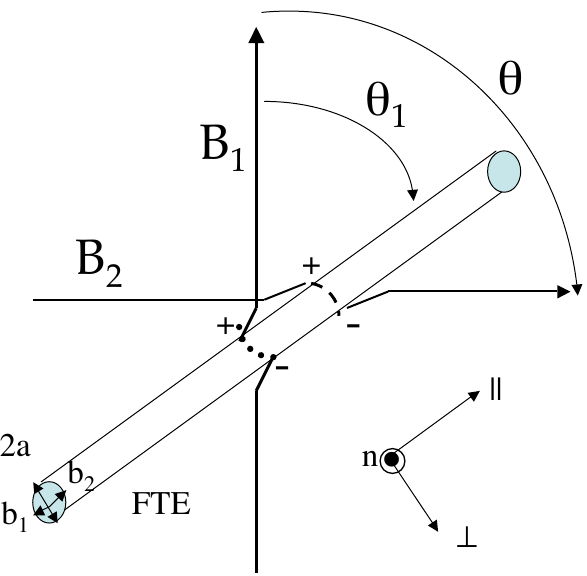
Fig. 1. A view of the dayside magnetopause from the Sun. The shear angle between the magnetosheath ( B 2 ) and magnetospheric ( B 1 ) magnetic fields is θ , whereas the angle between the axis of the FTE and the magnetospheric magnetic field is θ 1 . The northward magnetospheric magnetic field drapes under, whereas the duskward magnetosheath magnetic field drapes over, a flux transfer event whose axis runs from southern dawn to northern dusk. The draped field gains a positive (+ B n ) component normal to the nominal mag- netopause in both the magnetosheath and the magnetosphere on the northern edge of the event, but a negative ( − B n ) component on the southern edge. During the encounter with the event, the mag- netosheath magnetic field veers southward (dashed curve), while the magnetospheric magnetic field backs dawnward (dotted curve). Draped magnetic field strengths exceed those in the ambient media. The FTE has a dimension of 2a in the plane of the magnetopause, protrudes a distance b 1 into the magnetosphere, and a distance b 2 into the